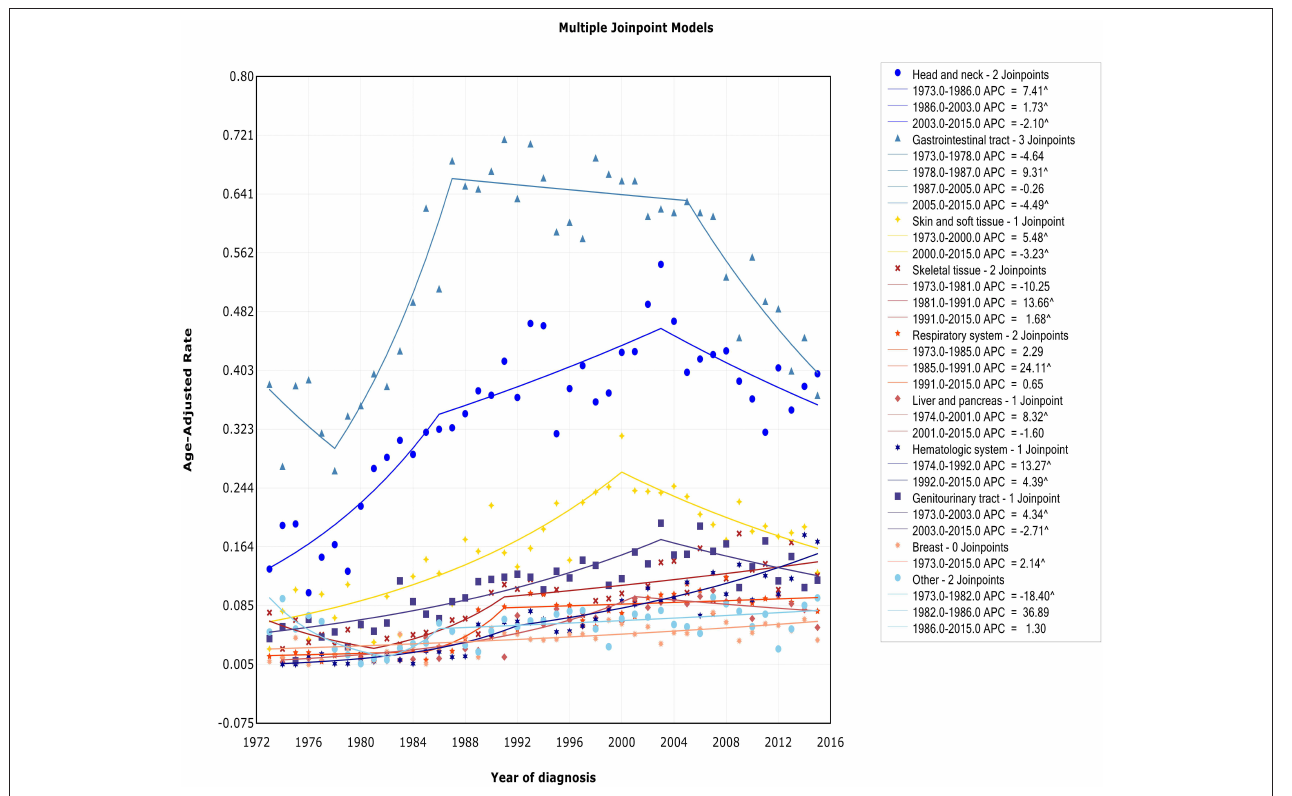
FIGURE 6 | Trends of annual incidence of extranodal DLBCL according to